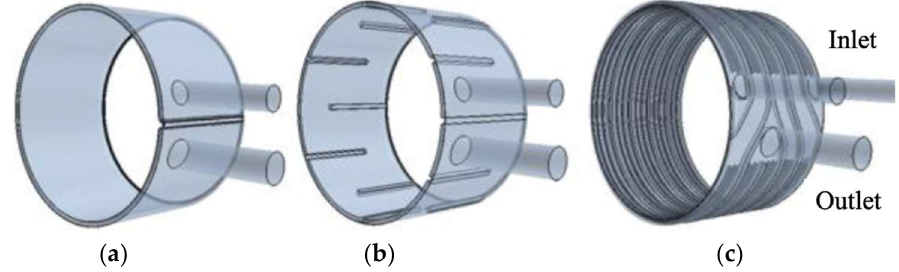
Figure 3. Cooling water jacket concepts [25]. ( a ) Circumferential. ( b ) Axial. ( c ) Spiral.